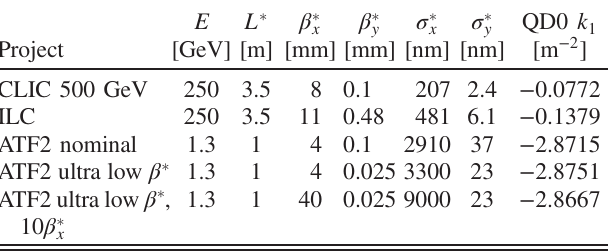
TABLE I. Comparison between relevant parameters of the considered beam